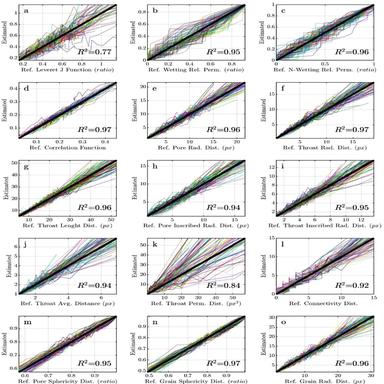
Comparison of the reference and estimated curves for 15 functions and distributions that correspond to the rows of 16 to 30 in 1 (plotted for randomly selected 100 samples and labeled with random colours).